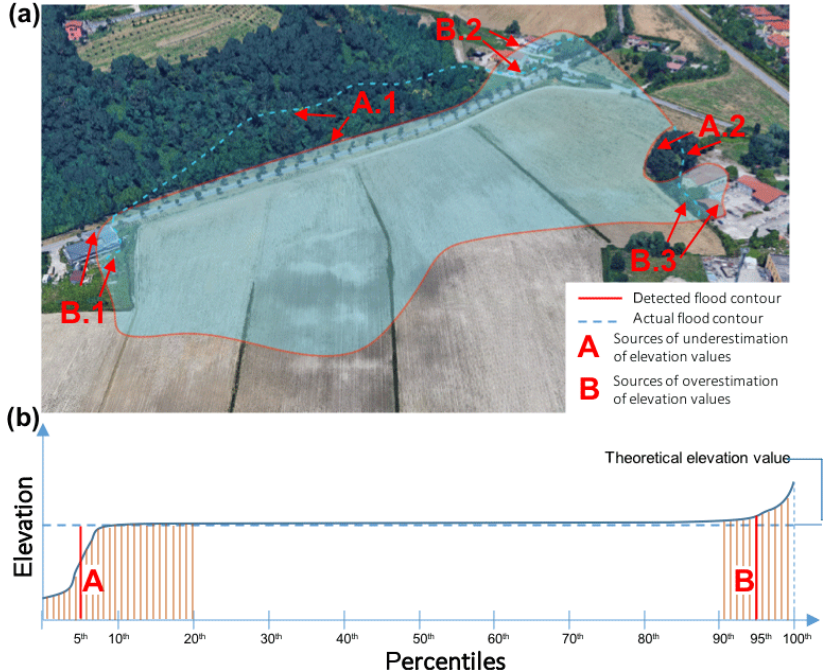
Figure 2. (a) Example of a detected flood polygon (light blue transparency) and relative flood boundary (red line). The dashed light blue line indicates the actual flood boundary, not correctly detected by the SAR-based flood map due to presence of vegetation obscuring the flood (cases indicated by the letter A) or due to radar shadow (cases indicated by the letter B). In the errors indicated by A, the elevation values detected are lower than the actual ones. Vice versa, in the errors indicated by B, the elevation values detected are higher than the actual ones. (b) Plot depicting the distribution function of the elevation along the boundary (red line). Areas indicated with A and B represent the values associated with the errors as explained above. The two threshold values (at the fifth and the 95th percentiles) are used to exclude